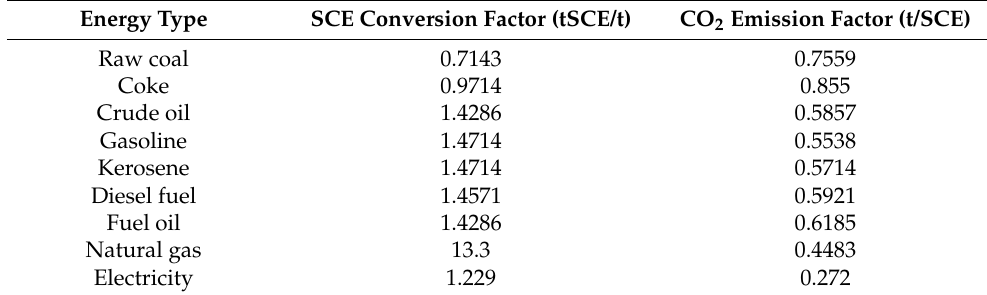
Table 2. Fossil energy emission